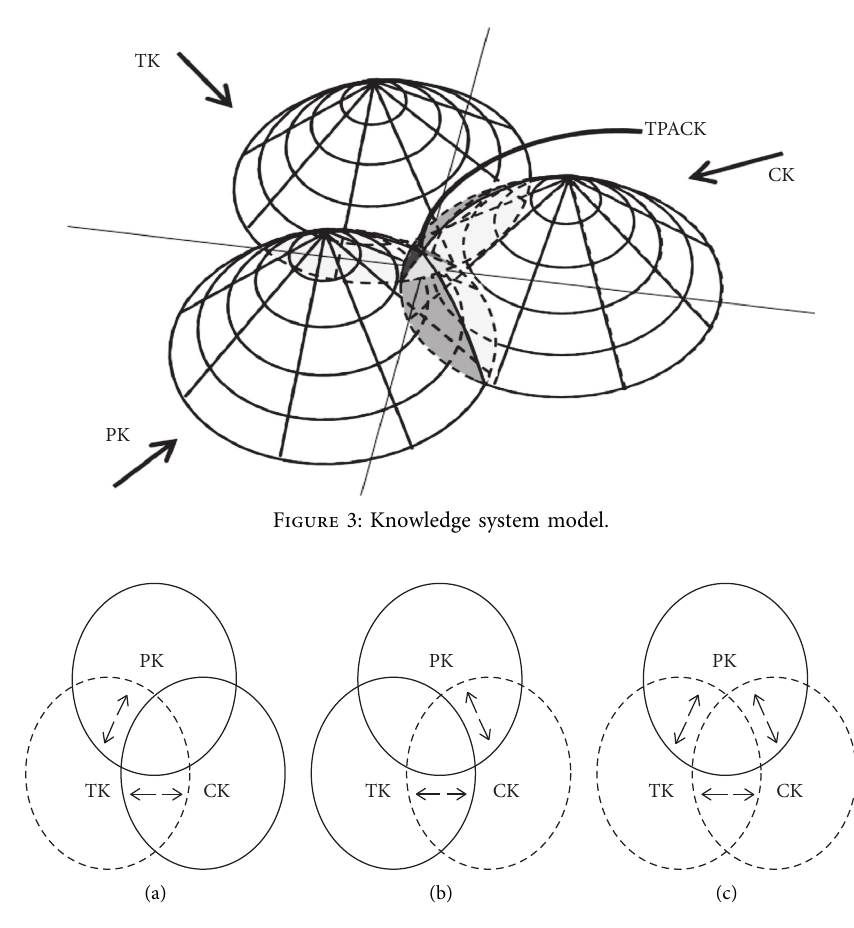
Figure 4: The absence of elements in TPACK system.